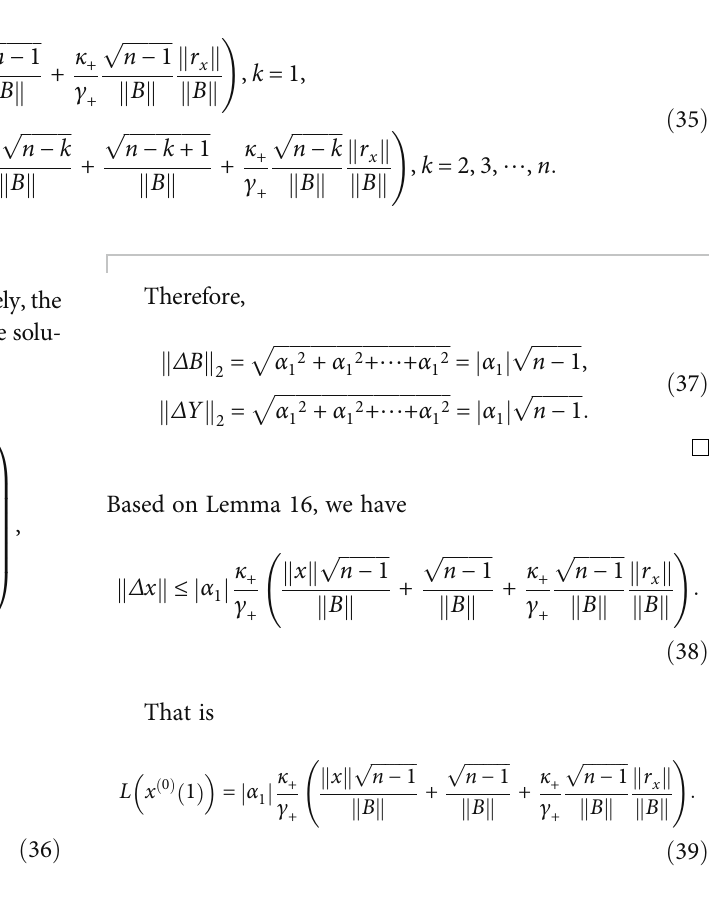
p ffiffiffiffiffiffiffiffiffiffi n − 1